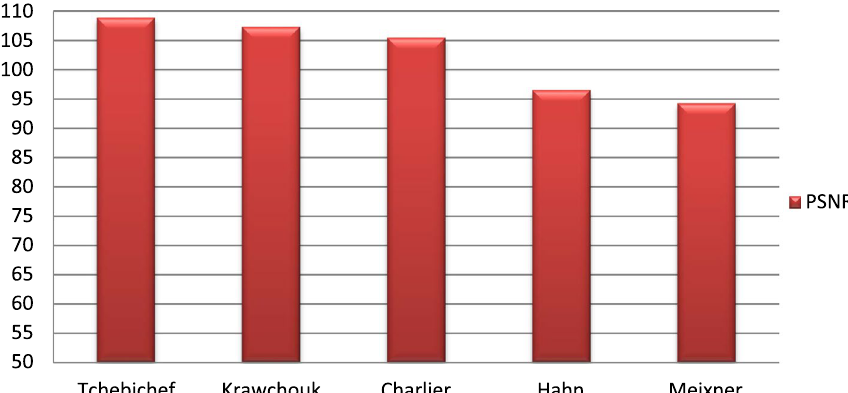
Fig. 6 The average PSNR of the reconstructed signals using Tchebichef, Krawtchouk , Charlier, Hahn, and Meixner moment with Householder method